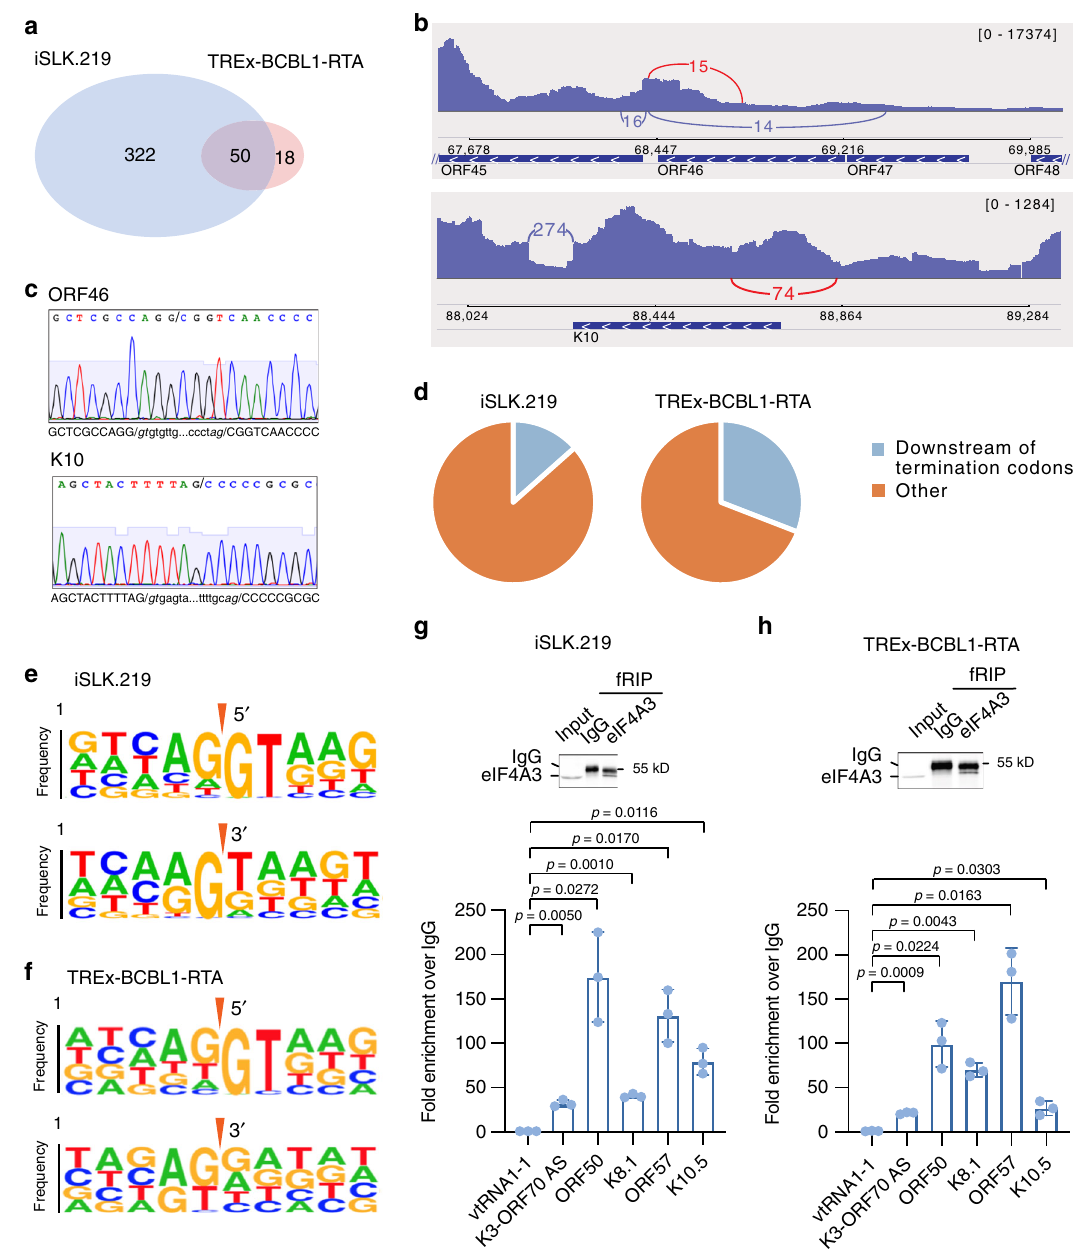
Fig. 1 Identi fi cation of pre-mRNA splicing events in the KSHV transcriptome. a Venn diagram illustrating the overlap of viral splicing events in iSLK.219 and TREx-BCBL1-RTA cells. b IGV view of pre-mRNA splicing events identi fi ed in ORF46 (upper panel) and K10 (lower panel). The novel pre-mRNA splicing events veri fi ed in c are labeled in red. c Veri fi cation of novel pre-mRNA splicing events in ORF46 and K10 by Sanger sequencing. d Pie chart depiction of the percentage of identi fi ed splicing events downstream of termination codons in viral transcripts. e , f kpLogo analysis of 5 ’ and 3 ’ splice sites in iSLK.219 ( e ) and TREx-BCBL1-RTA cells ( f ). g , h Veri fi cation of the association of viral transcripts with eIF4A3 by fRIP-qPCR in iSLK.219 ( g ) and TREx- BCBL1-RTA cells ( h ) 48 h post-Dox treatment. Upper panels are western blot of cell lysis (Input) and fRIP products (representative of three independent experiments). Lower panels are RT-qPCR analyses of eIF4A3 fRIP. Data are presented as mean values ± SD ( n = 3 biologically independent samples). p -values were determined by the two-tailed Student ’ s t -test. Source data are provided in Source Data fi